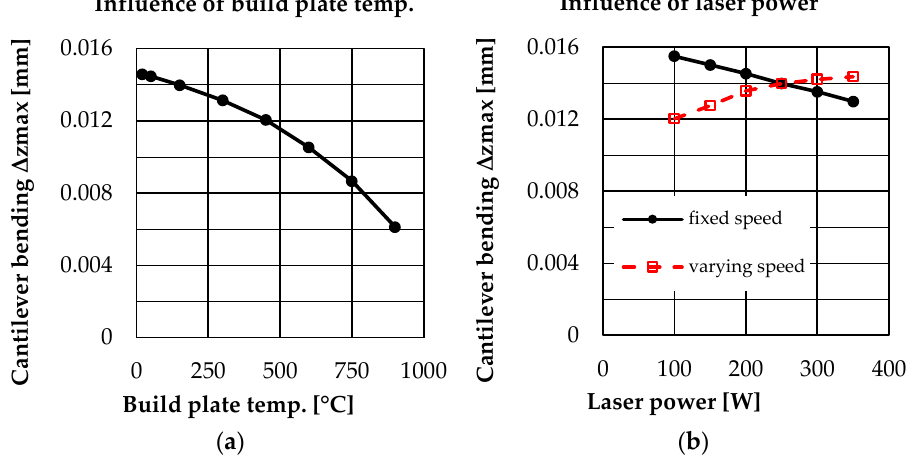
Figure 9. Maximum bending at cantilever front position dependent on build plate temperature ( a ) and laser power ( b )— fi xed speed brings variation in LED—varying speed keeps LED constant.